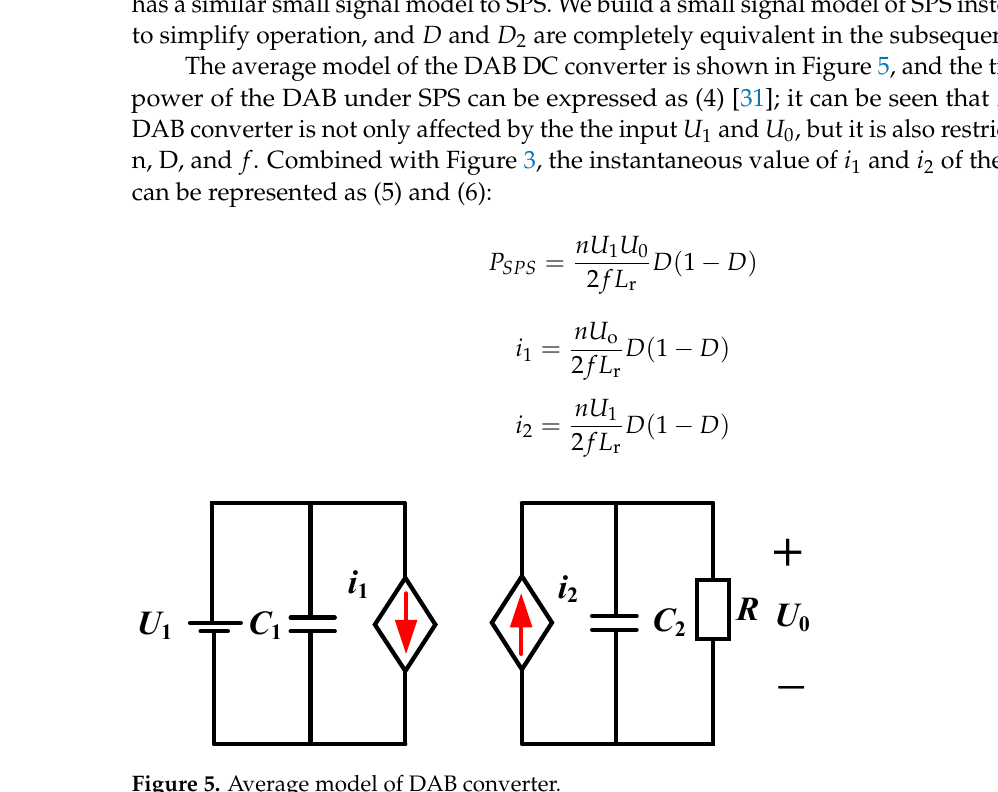
Figure 5. Average model of DAB converter .